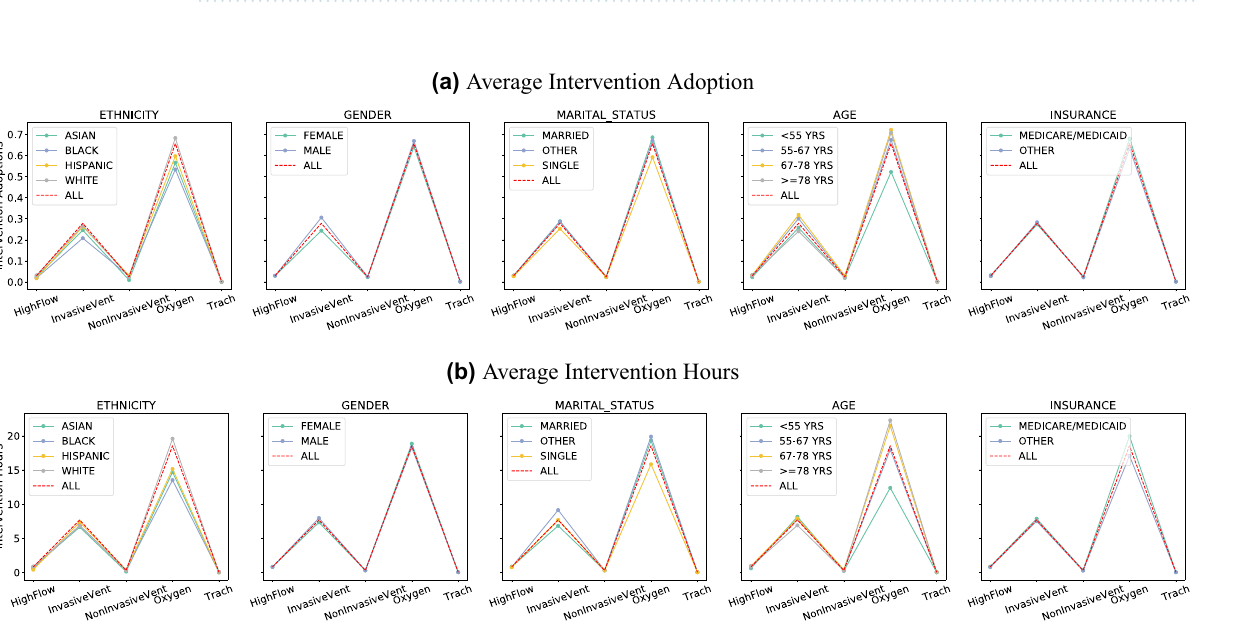
Table 6. Protected attributes and subgroups within MIMIC-IV.